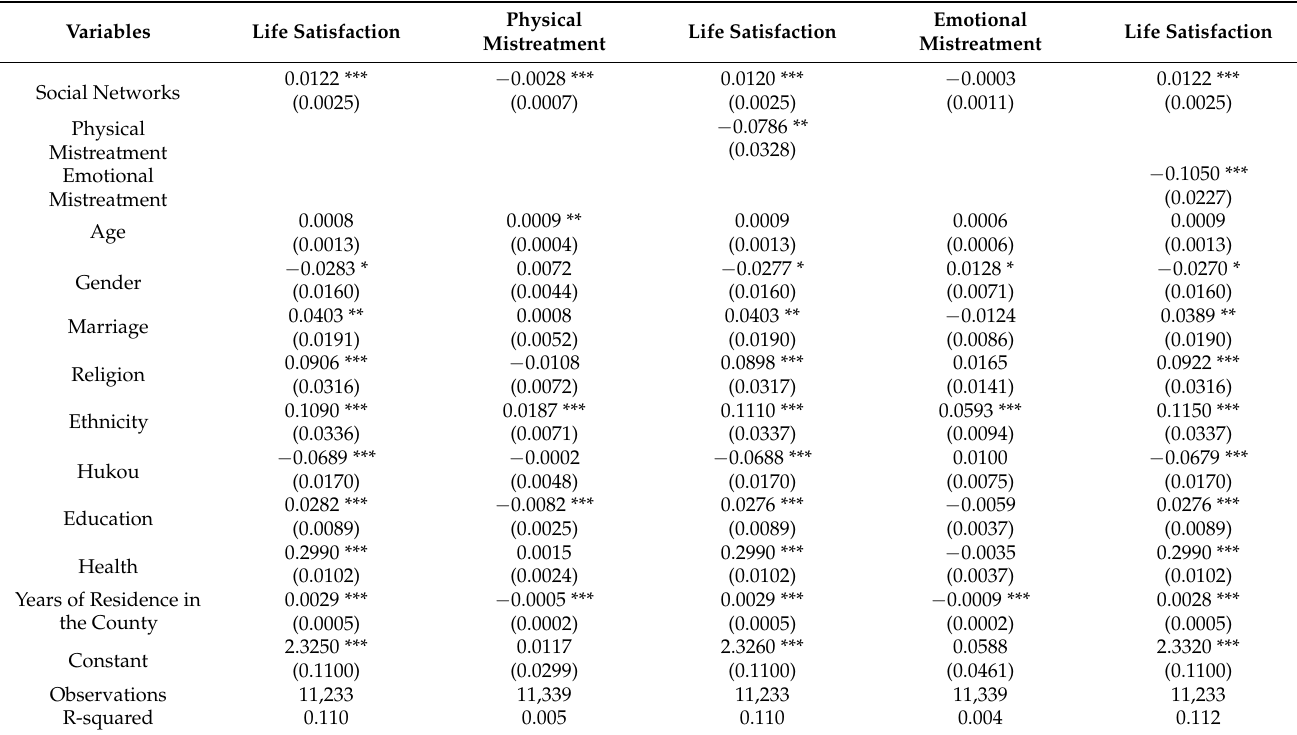
Table 6. Test of the mediating effect of social